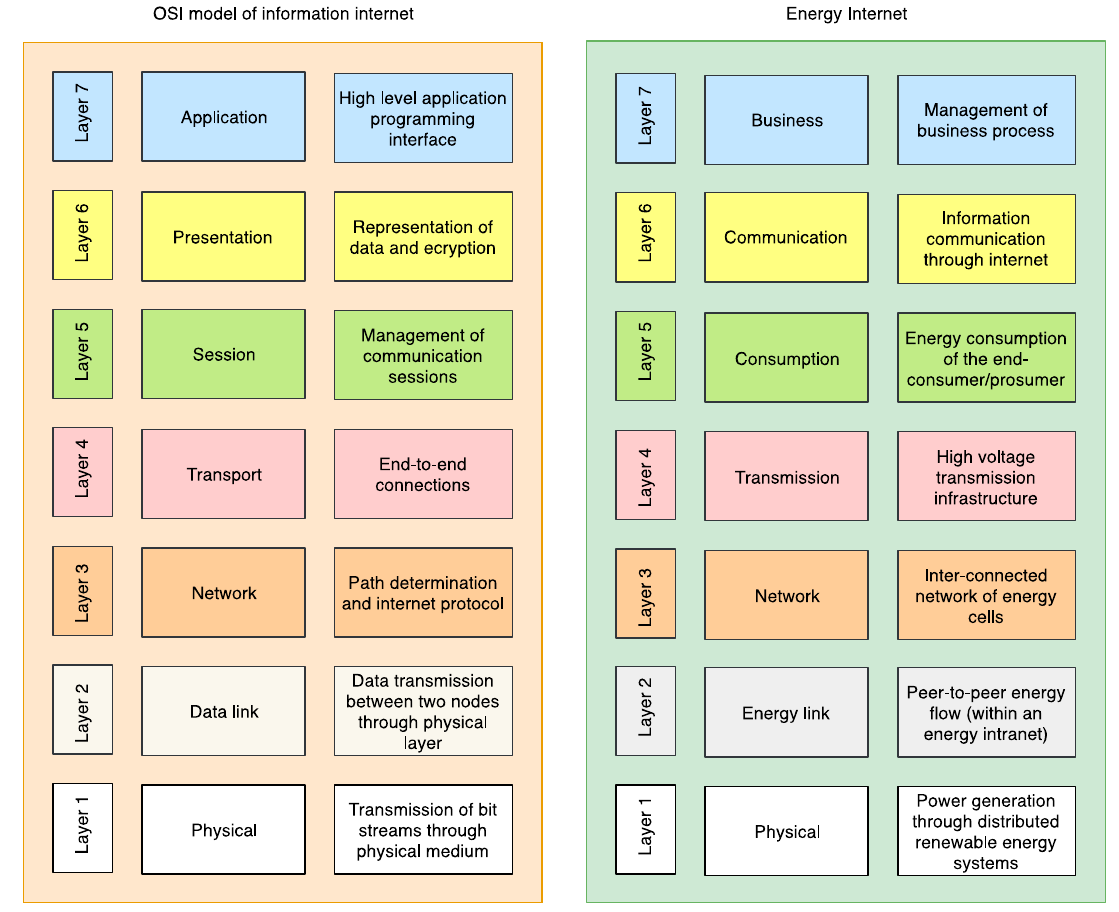
Figure 5. Open Systems Interconnection model (OSI) reference model and proposed seven-layer architecture. Source: OSI model [49] and Energy Internet Architecture (Authors’ contribution).